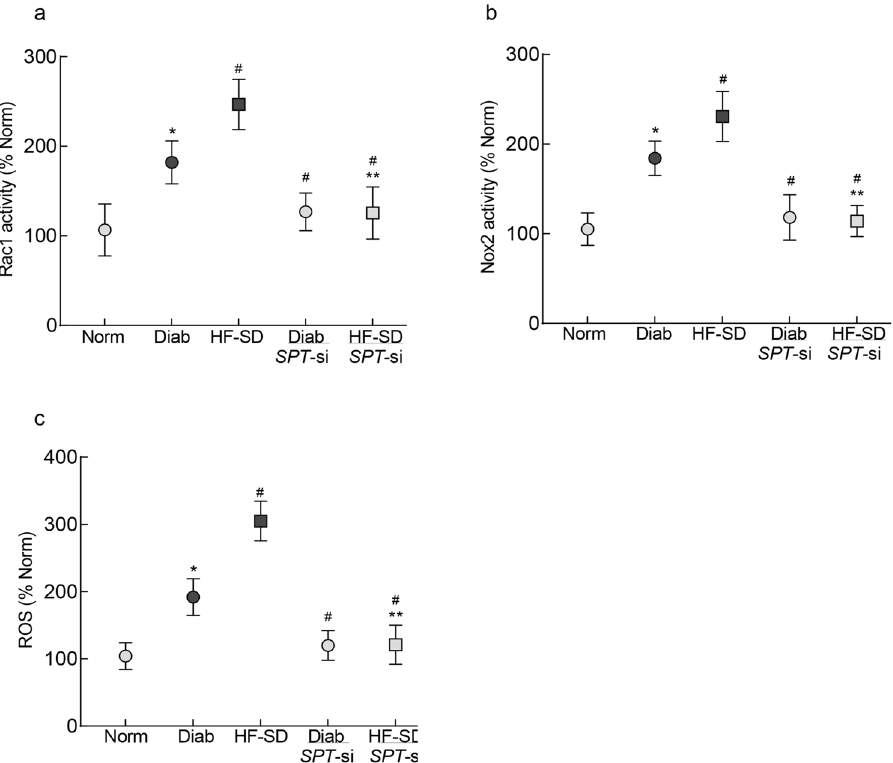
Figure 6. Rac1–Nox2–ROS signaling and SPT inhibition in retinal microvessels from diabetic mice. Retinal microvessels were analyzed for ( a ) Rac1 activity, ( b ) Nox2 activity, and ( c ) ROS by DCHFDA method. Each measurement was made in duplicate, and the values are means ± SD of 5–7 mice/group. Norm = normal mice on regular chow; Diab = diabetic mice on regular chow; HF-SD = diabetic mice on high fat chow; Diab /SPT -si or HF-SD/ SPT -si = SPT -siRNA administered diabetic mice on regular chow or high fat chow, respectively. *p < 0.05 vs Norm, # p < 0.05 vs Diab and # **p < 0.05 vs